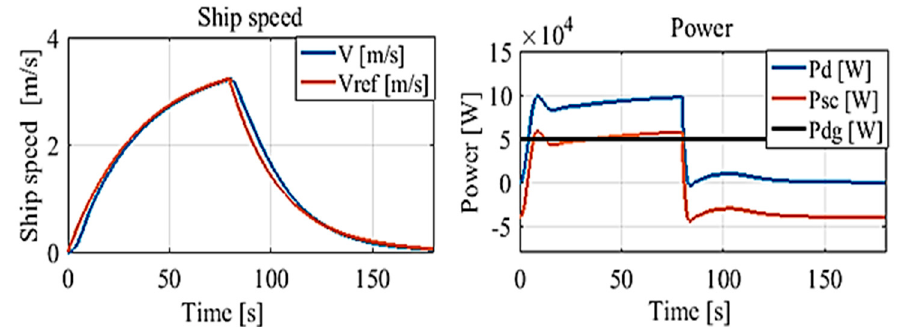
Figure 8. Simulation results for the SC based on case.